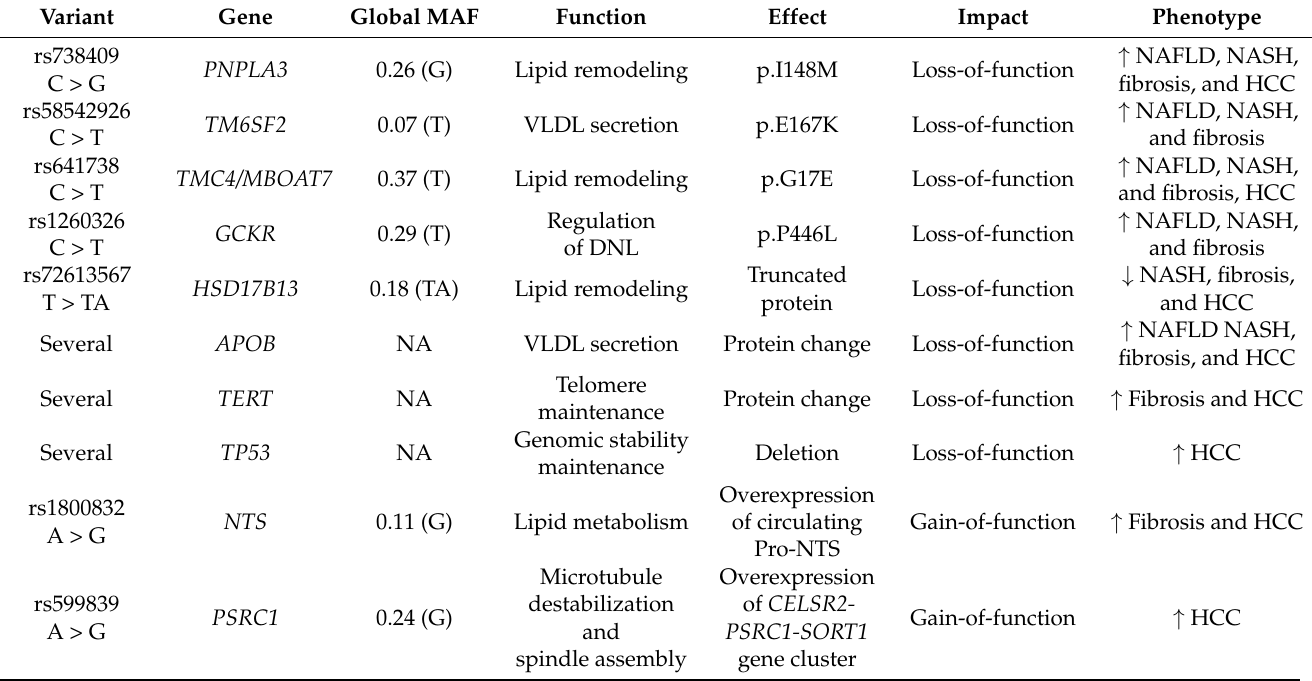
Table 2. Schematic list of the main inherited variations related to